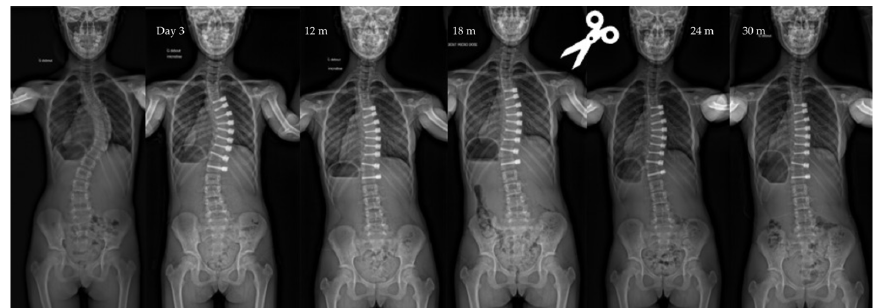
Figure 4. Radiographs of a 11-year-old patient, Risser 0, TRC open, with a main thoracic curve. The curve measured 57° pre-operatively, improved to 26° after surgery, to 11° at last follow-up (2.5 y po). The patient was revised 1.5 po for tether release between T10 and L11. Note the control of the overcorrection after the revision.